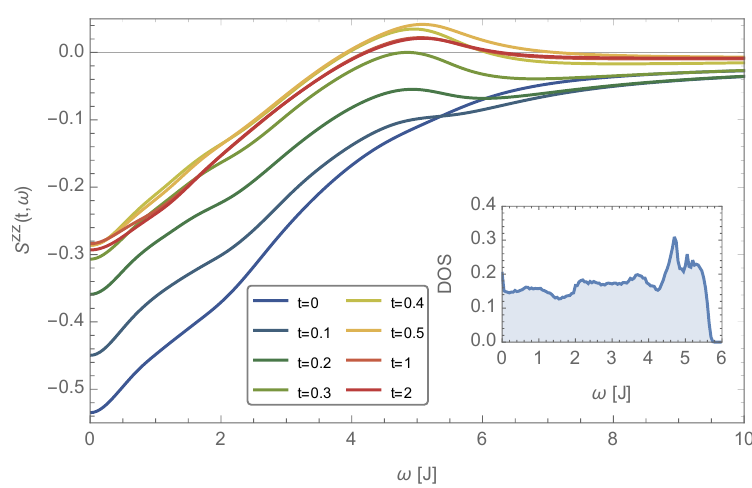
Figure 7: The dynamical two-time response in the isotropic quench, as a function of frequency ω for various waiting times t . Directly after the quench ( t = 0) the peak at ω = 0 indicates strong antiferromagnetic correlations. This peak is sup- pressed as time progresses, consistent with the loss of magnetization, see Fig. 1. After t ∼ 0.3 J − 1 the small frequency peak remains constant, and a dynamic mag- netization reversal occurs in the frequency range between 4 − 6 J, where the flux- averaged Majorana density of states (see inset) is highest and corresponding to the triplet excitation in the valence-bond